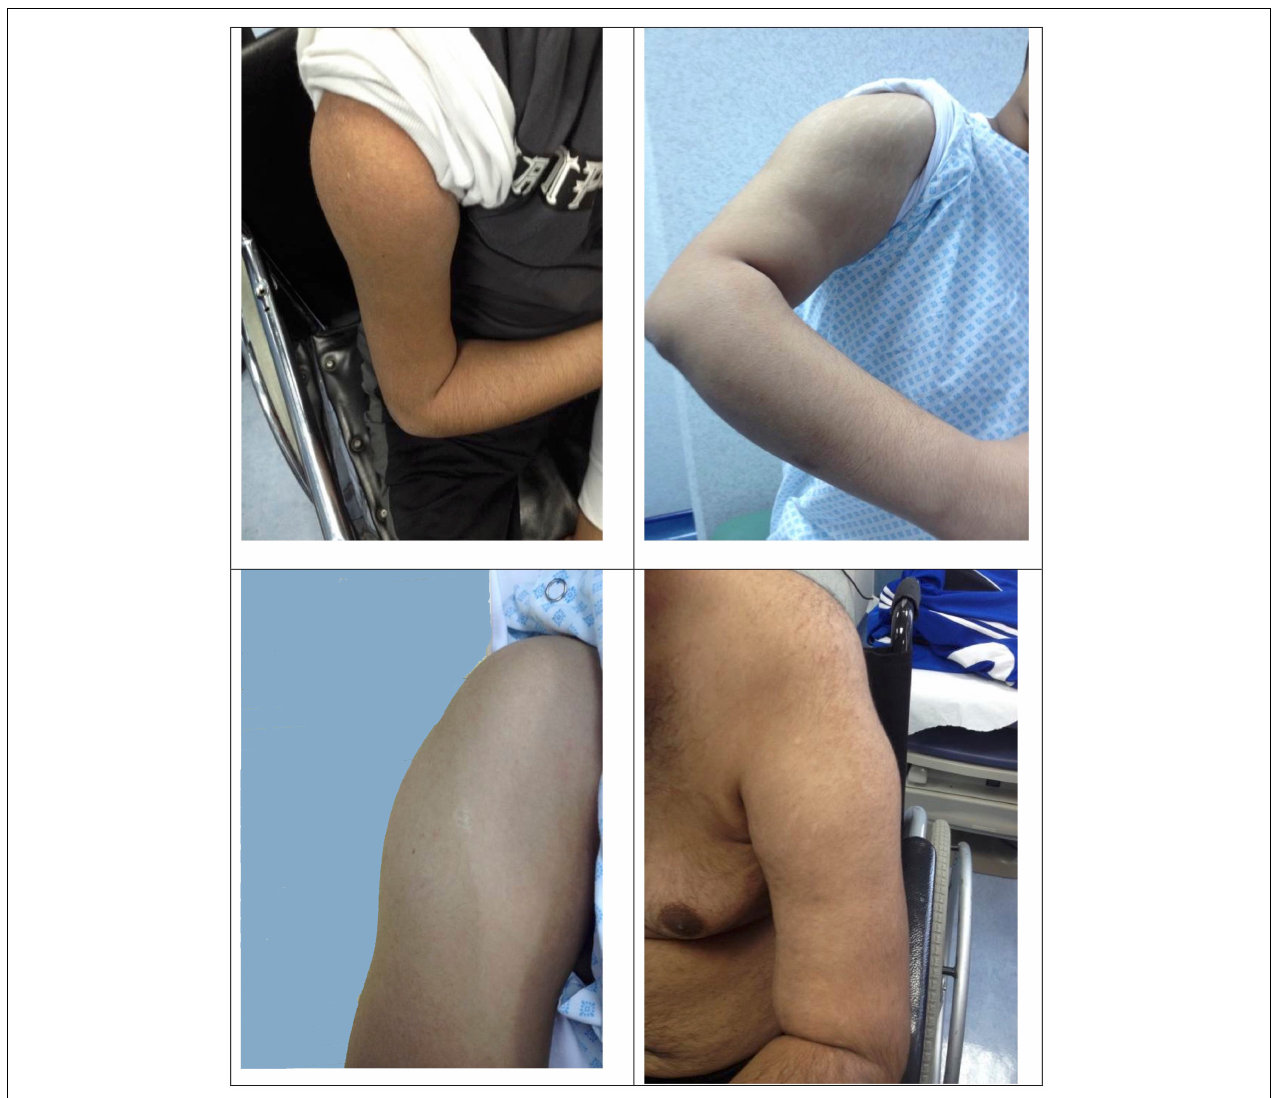
FIGURE 2 | Deltoid